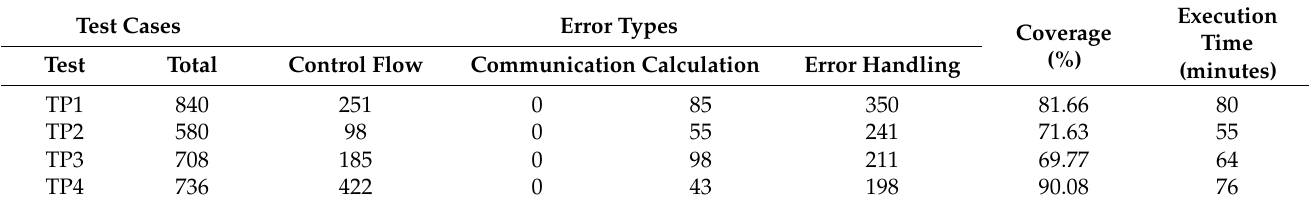
Table 1. Improved fault coverage results for offline